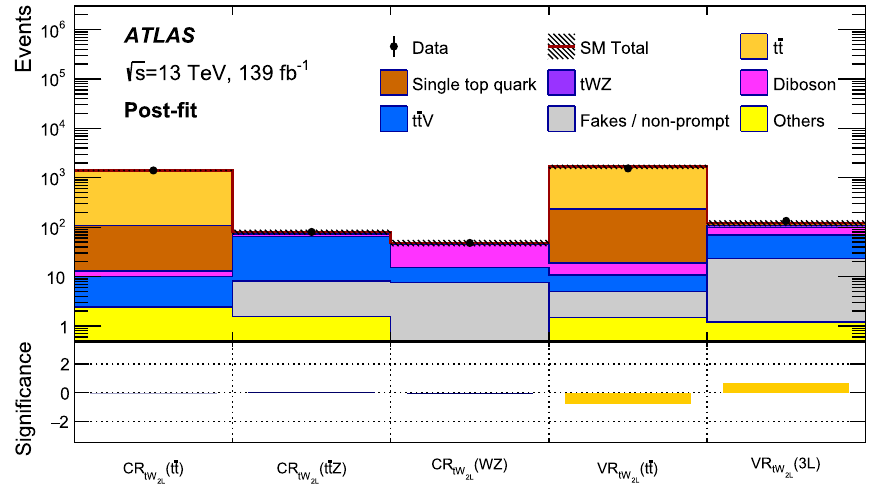
Fig. 5 Comparison of the predicted backgrounds with the observed numbersofeventsintheCRsandVRsassociatedwiththetW 2L channel. Thenormalisationofthebackgrounds isobtainedfromthebackground- only fit to the CRs. The ‘Others’ category includes contributions from rare processes such as triboson, t ¯ tt ¯ t , t ¯ tWW , and Higgs boson produc-